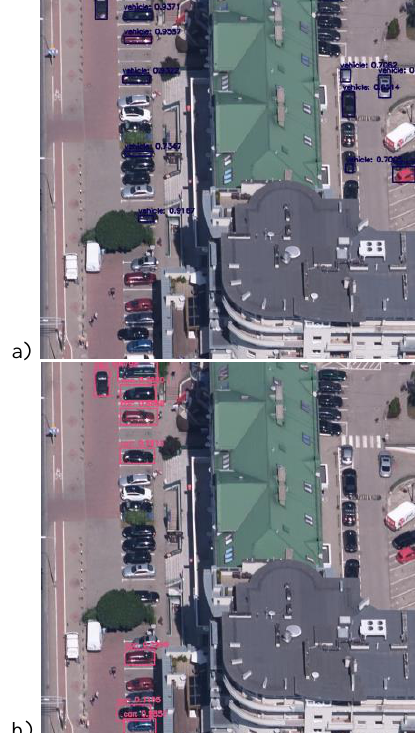
Figure 4 Example where detection results from YOLO learned on two different image sets partially complement each other: a) MSCOCO, b) DIOR – for images from Elblag dataset.